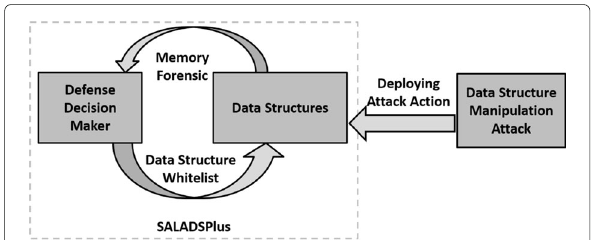
Fig. 1 Overview of how DSSR Binary defends against